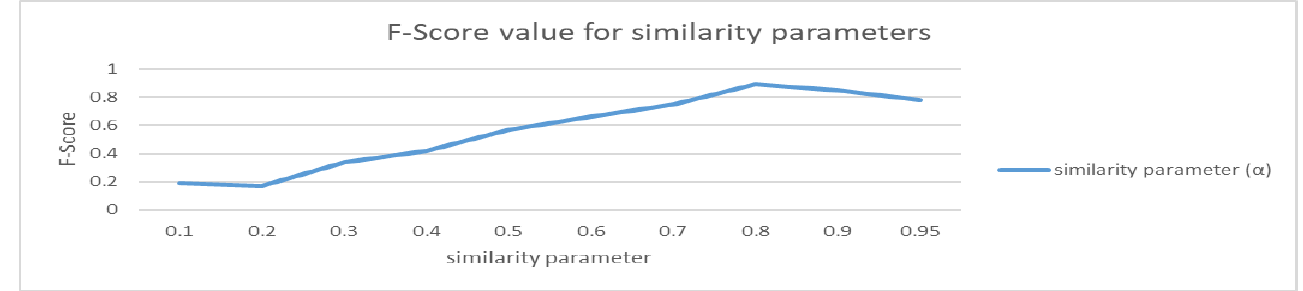
Figure 7. Average feature vector parameter against F-Score.